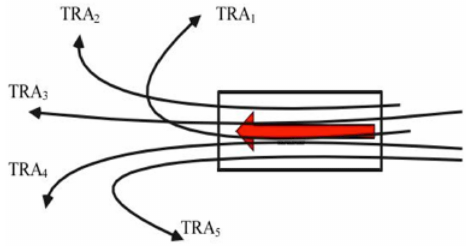
Figure 2. Example of motion pattern.